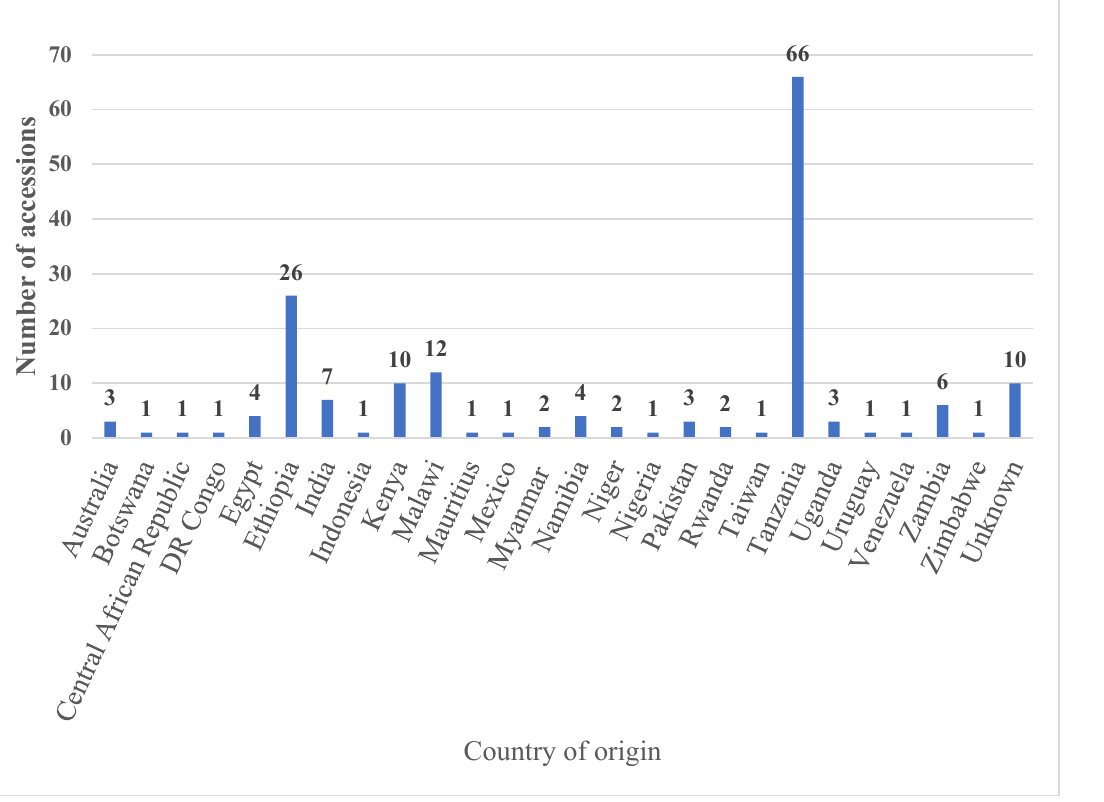
Figure 9. Sesbania sesban accessions studied by their country of origin.